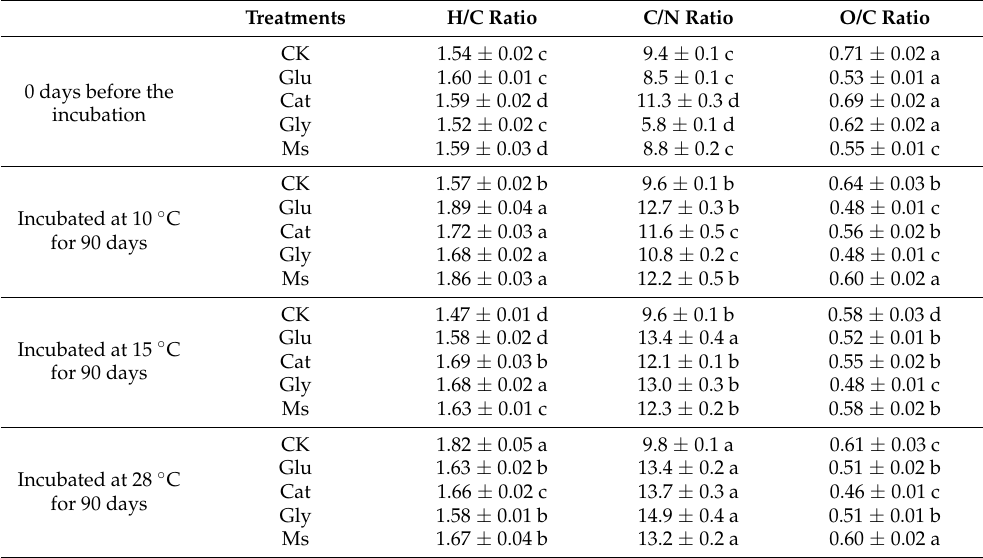
Table 1. Atomic ratio of HLA extracted from the decomposing material of rice straw at different incubation temperatures. Treatments H/C Ratio